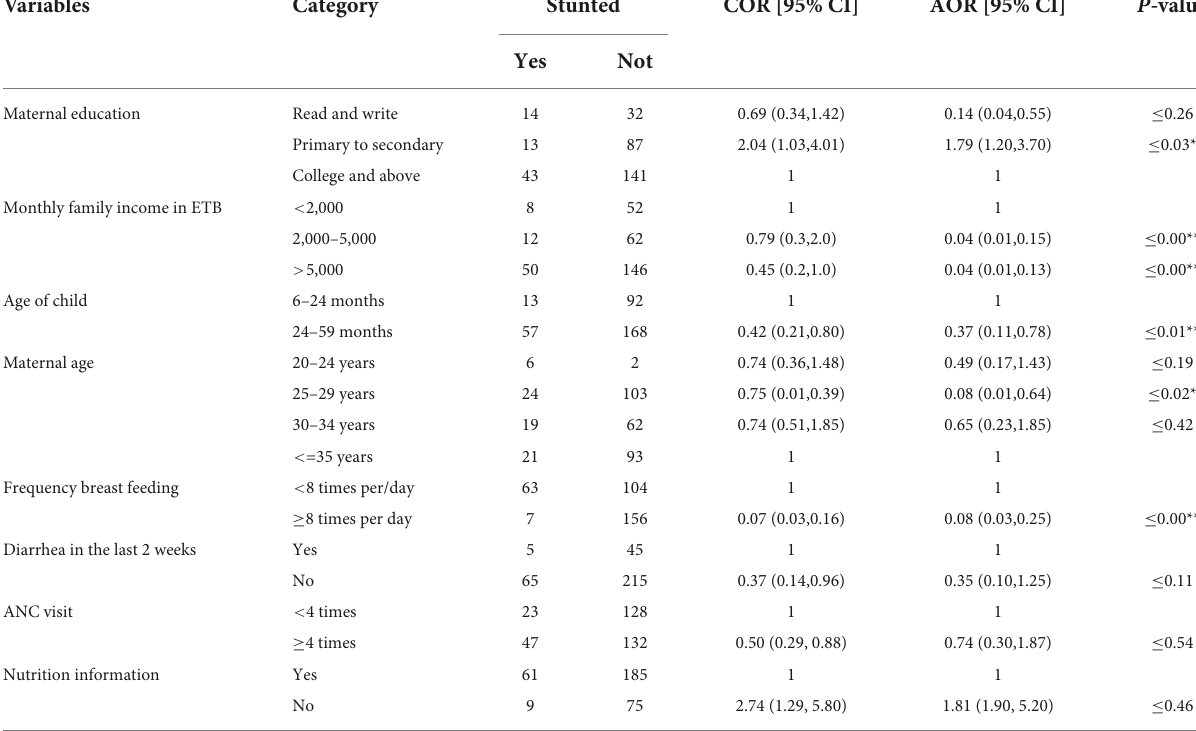
TABLE 2 Bivariate and multivariate analysis for stunting among employed mothers in Gurage Zone, SNNPR, Ethiopia 2021 ( n = 671). Variables Category